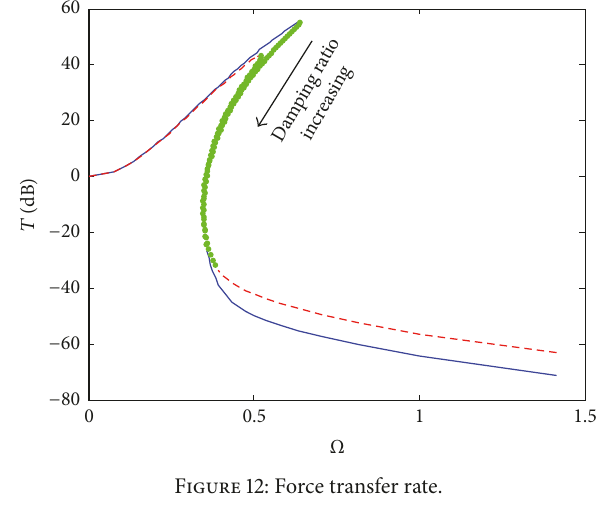
Figure 12: Force transfer rate.